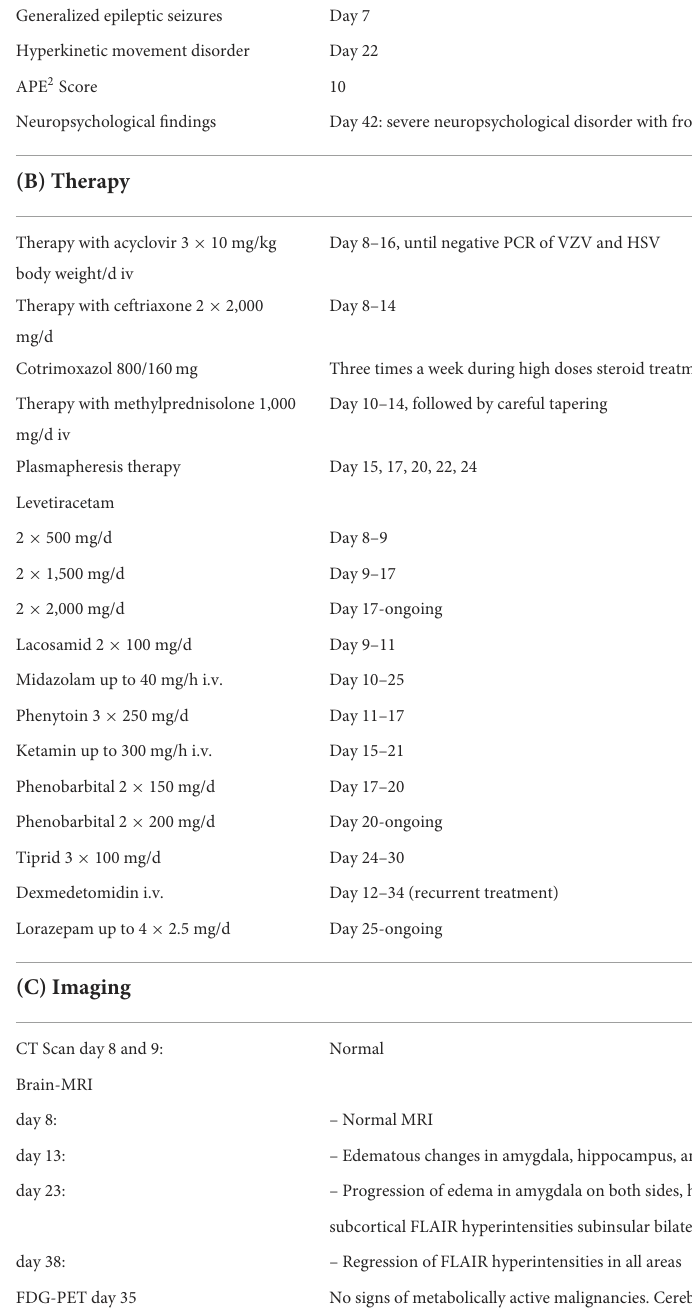
TABLE 1 (A) Symptoms and (B) therapy, (C) imaging, (D) laboratory, (E) CSF, and (F) EEG findings. (A) Symptoms SARS-CoV-2 vaccination Day 0 Fever, headache, change of character, skin